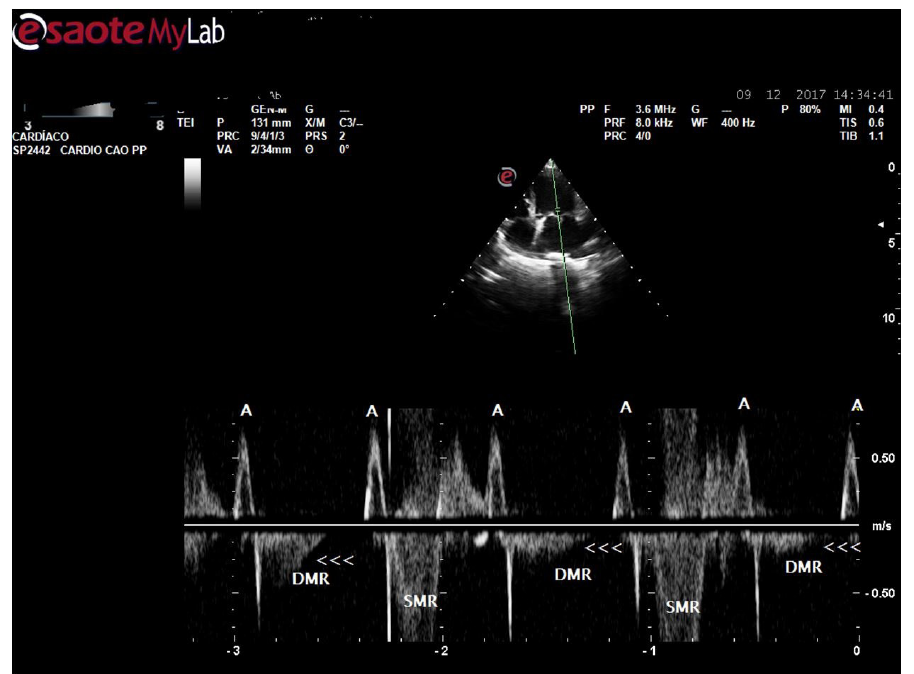
Figure 2. Pulsed spectral Doppler of transmitral flow. The atrial waves (A) are dissociated of ventricular contractions. The systolic mitral regurgitation (SMR) had velocity exceeding the Nyquist limit and the signal was aliased. Weak jet of diastolic mitral reflux (DMR) is shown.